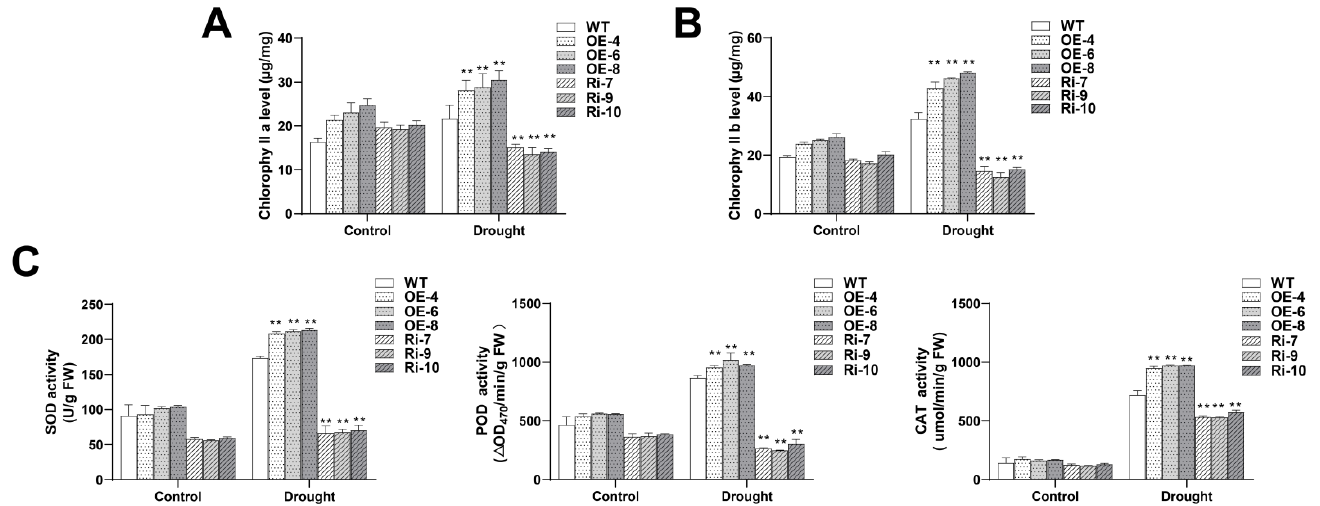
Figure 6. The determination of drought related physiological alternation under natural drought stress. ( A ) Analysis of chlorophyll a content of WT, OE- BrDHC1 , and RNAi- BrDHC1 transgenic plants (data represent the means ± SD of 6 replicates; Student’s t test was performed to compare differences between the wild-type and the transgenic plants under natural drought stress, ** p value < 0.01). ( B ) Analysis of chlorophyll b content of WT, OE- BrDHC1 , and RNAi- BrDHC1 transgenic plants (data represent the means ± SD of 6 replicates; Student’s t test was performed to compare differences between the wild-type and the transgenic plants under natural drought stress, along with one-way analysis of variance (ANOVA), ** p value < 0.01). ( C ) Analysis of antioxidant enzyme activities in wild-type, OE- BrDHC1 , and RNAi- BrDHC1 transgenic plants under drought stress (data represent the means ± SD of 6 replicates; Student’s t test was performed to compare differences between the wild-type and the transgenic plants under natural drought stress, along with one-way analysis of variance (ANOVA), ** p value < 0.01).